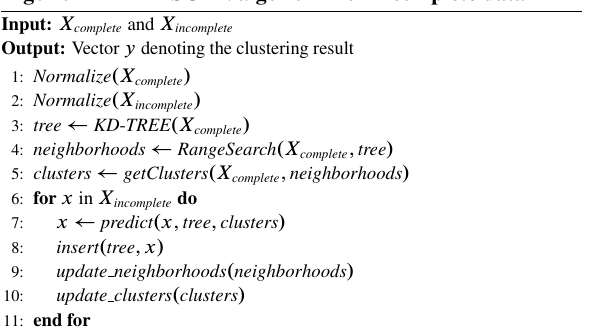
Algorithm 1 DBSCAN algorithm for incomplete data